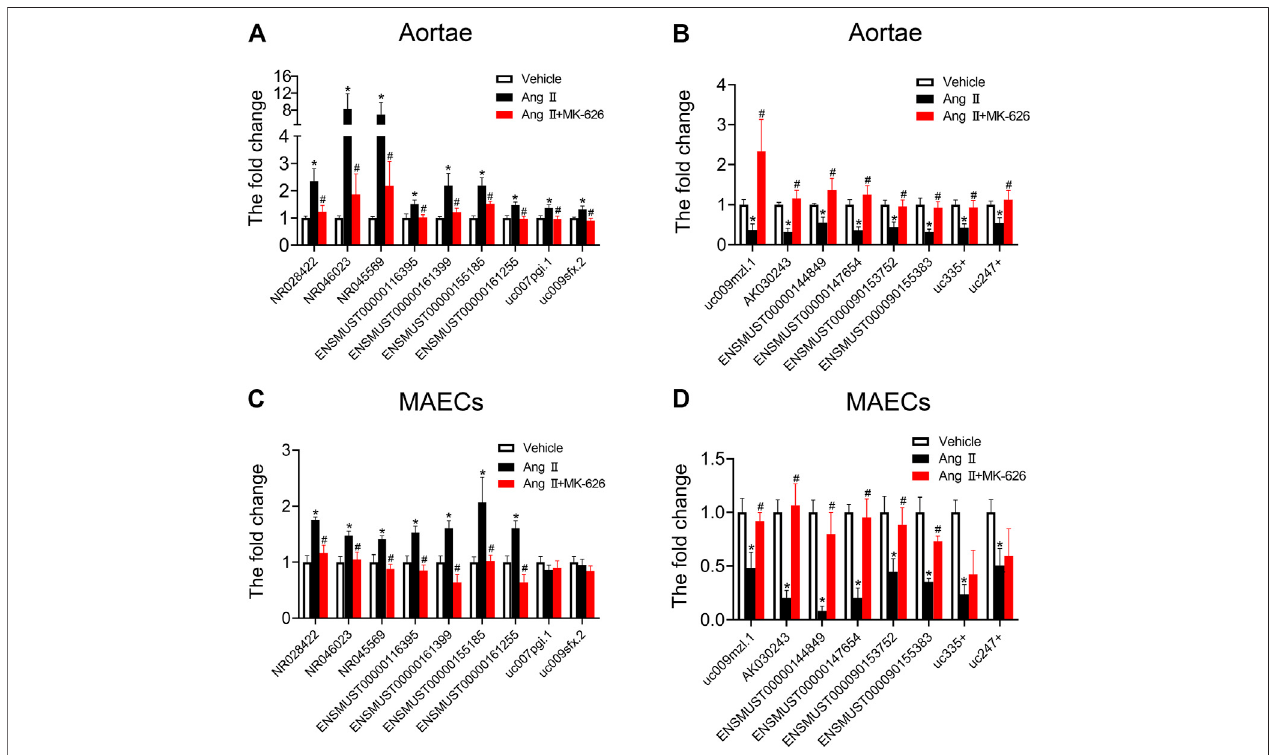
FIGURE 3 | Quantitative real-time PCR validation. qRT-PCR validated the expression of upregulated and downregulated lncRNAs in the mouse aortae (A – B) and aortic endothelial cells (C – D) . * p < 0.05 vs Vehicle; # p < 0.05 vs Ang Ⅱ . Data are expressed as mean ± SEM ( n (cid:1) 6 – 9 for aortae, n (cid:1) 4 – 6 for endothelial cells).